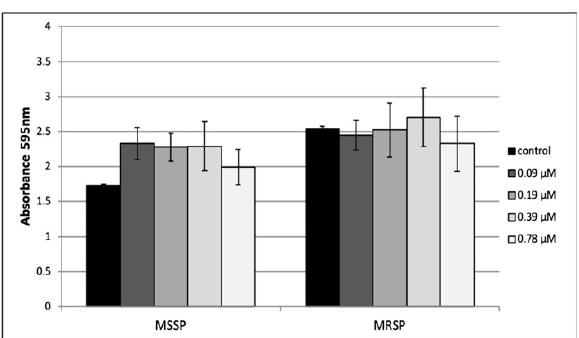
Figure 2. Effect of sub-MIC peptide 8 concentrations on MSSP and MRSP biofilm formation assessed by crystal violet assay. Experiments were performed in triplicate in three independent experiments.